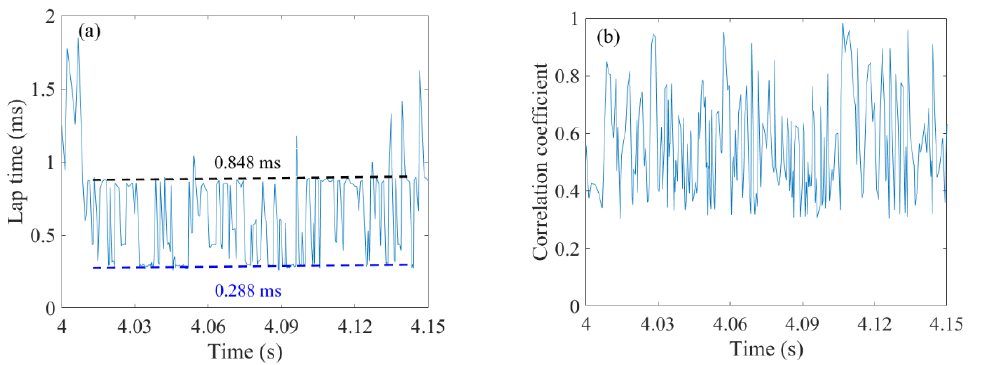
Figure 6. Autocorrelation results of B10 (4.0–4.16 s): ( a ) lap time and ( b ) correlation coefficient.